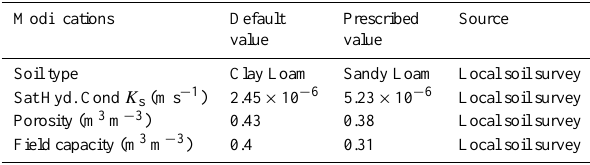
Table 4. Modifications to model soil parameters, based on literature and local soil data.